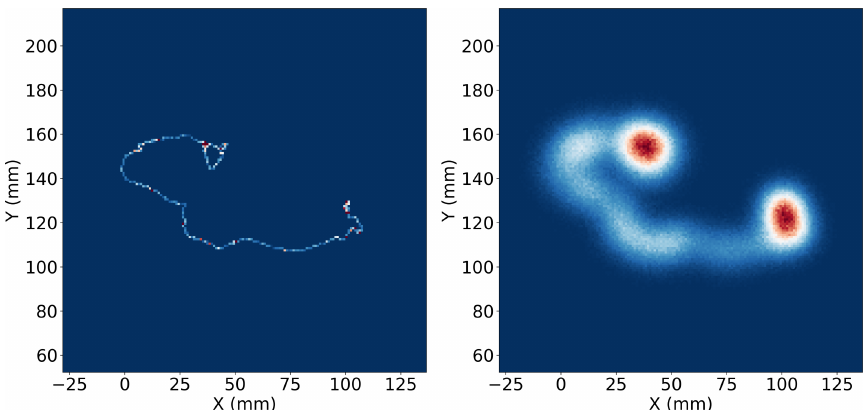
Figure 3 . Simulated 136 Xe 0 νββ event. Left: initial track; right - same track after drifting 40 cm considering the longitudinal and transverse diffusion coefficients to be 0.27 mm / √ 1.07 mm / cm respectively. Color scale in the right plot represents the number of ionization elec- trons at each xy